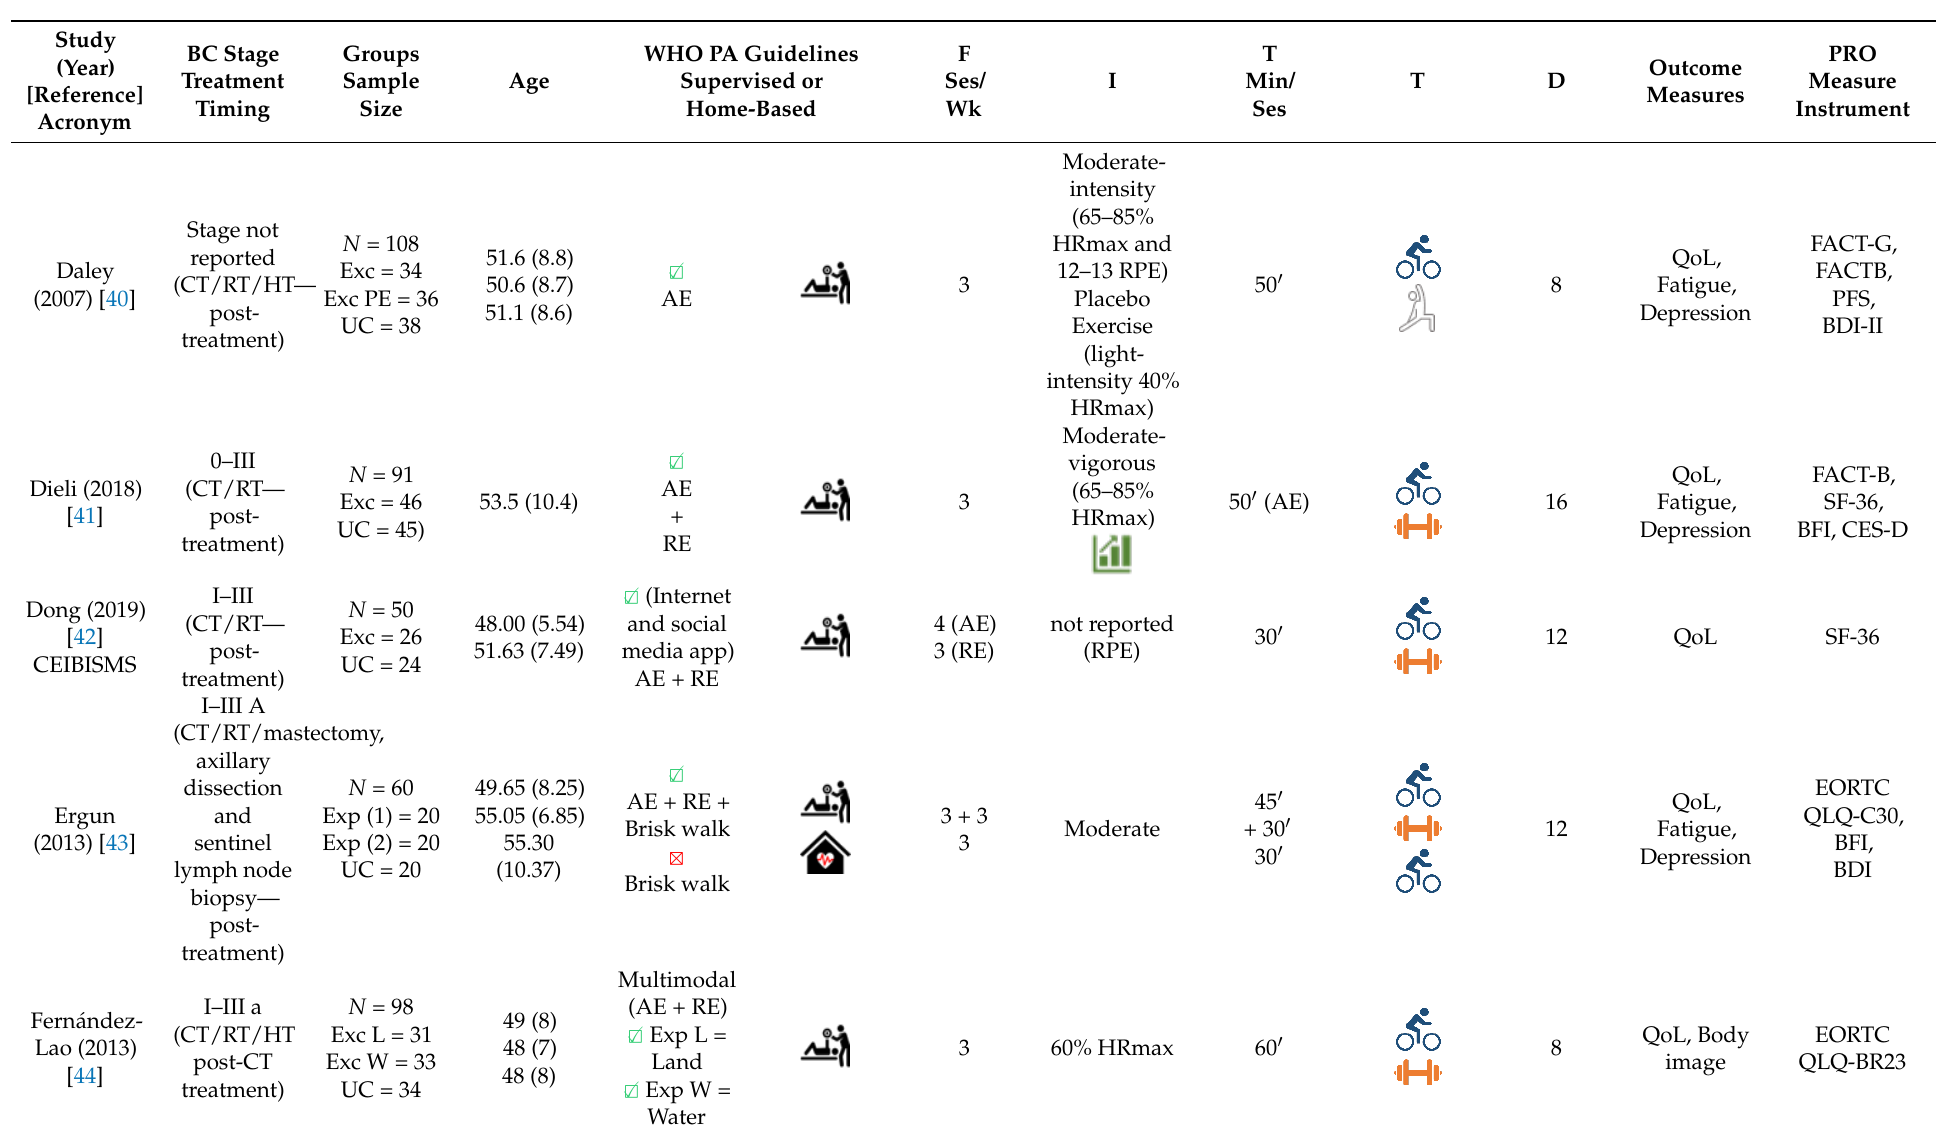
Frequency, Intensity, Time and Type (FITT); Duration (D); Patient Reported Outcome (PRO); Exercise intervention group (Exc); Usual care or control group (UC); Aerobic Exercise training (AE); Resistance Exercise training (RE); WHO guidelines of minimum physical activity/exercise recommended ( : accomplished; not accomplished); Chemotherapy (CT); Radiotherapy (RT); Hormonal Therapy (HT); Quality of Life (QoL); ratings of perceived exertion (RPE); moderate to vigorous physical activity (MVPA); Heart Rate Reserve (HRR); Ductal Carcinoma in Situ (DCIS); PRO measures: Beck Depression Inventory (BDI); The Brief Fatigue Inventory (BFI); European Organization for Research and Treatment of Cancer Quality of Life Questionnaire (EORTC QLQ-C30); Finnish modified version of Beck’s 13-item depression scale (RBDI); Functional Assessment of Cancer Therapy, FACT-Anemia (FACT- A); Functional Assessment of Cancer Therapy-Anemia (FACT-An); Breast (FACT-B); Fatigue (FACT-F); General (FACT-G); Functional Assessment of Chronic Illness Therapy (FACIT); questionnaire for fatigue (FACIT-F); Medical Outcomes Study Short Form (MOS SF-36); Piper Fatigue Scale (PFS); Schwartz Cancer Fatigue Scale (SCF); Women’s Health Questionnaire (WHQ); Patient Reported Outcomes Measurement Information System (PROMIS); Body Image Scale (BIS); Happiness Measure (HM); Social Physique Anxiety Scale-7 items (SPAS-7); Memorial Symptom Assessment Scale (MSAS); Fatigue Assessment Questionnaire (FAQ); Hospital Anxiety and Depression Scale (HADS); HADS-Anxiety (HADS-A); HADS-Depres- sion (HADS-D); Pittsburgh Sleep Quality Index (PSQI); Rosenberg Self-Esteem scale (S-ES); Center for Epidemiological Studies Depression Scale (CES-D); Spielberger State Anxiety Inventory (SAI); Physical Function scale (SF-36); World Health Organization Quality of Life-BREF (WHOQOL-BREF); State-Trait Anxiety Inventory, (STAI); STAI-State Anxiety (STAI- YI), Cohen’s 10-item Perceived Stress Scale (10-PSS); Trial Outcome Index-Anemia (TOI-An) subscale and fatigue subscale; Health Related Quality of Life (HRQoL); Profile of Mood States (POMS); Linear analog scale for fatigue (LASF); Cancer Rehabilitation Evaluation System-Short Form (CARES-SF); Body Image and Relationships Scale (BIRS). * Age presented with mean and SD or range where